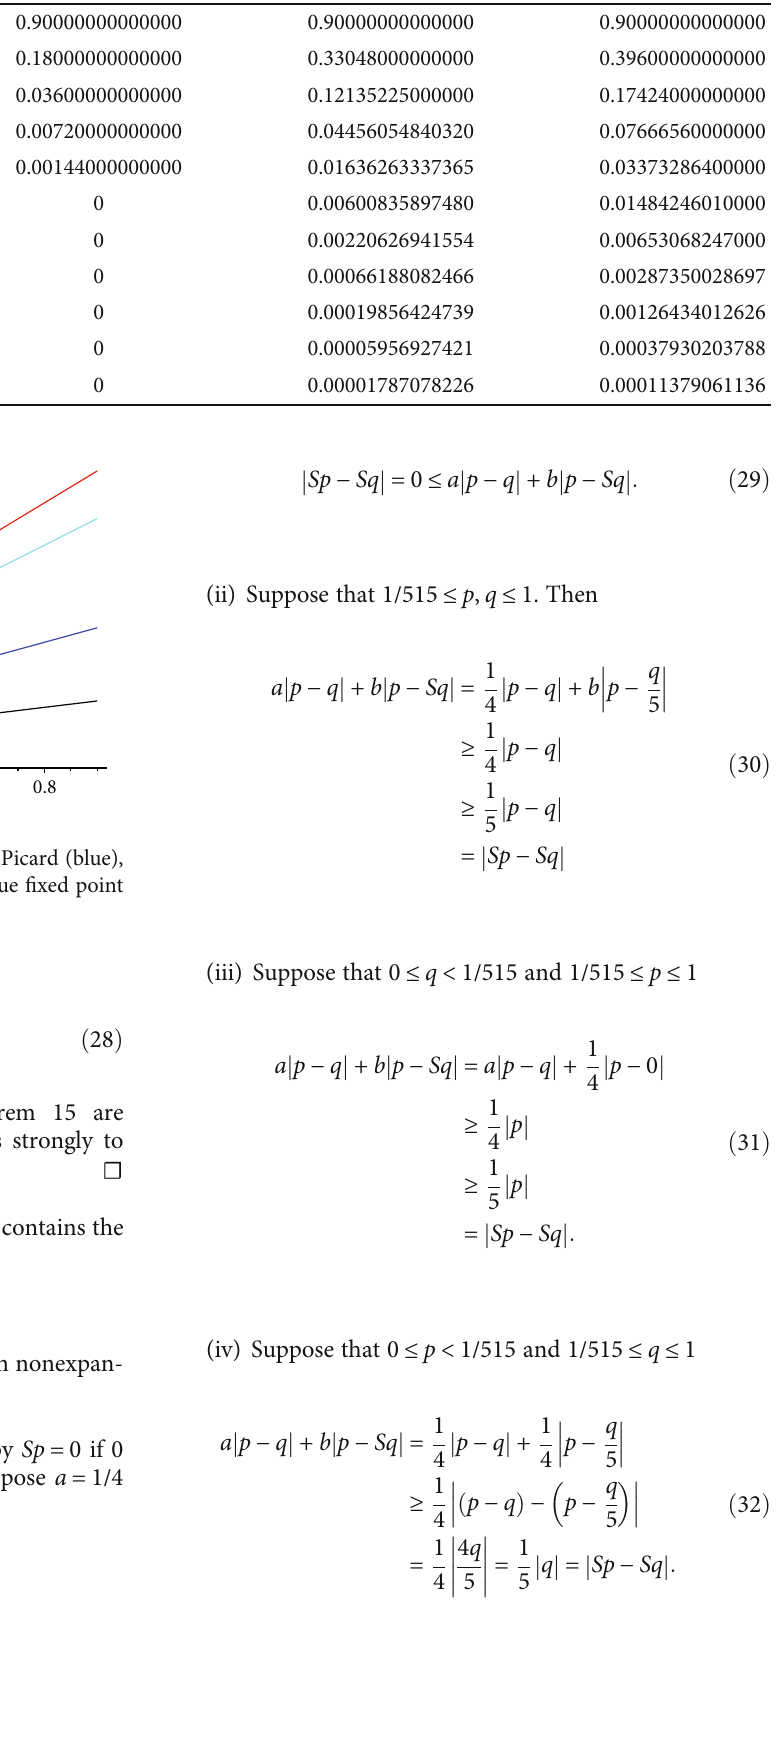
Table 1: Strong convergence of Picard – Mann hybrid, Picard, Ishikawa and Mann iterations to the fi xed point e m Picard-Mann hybrid (7) Picard (4)